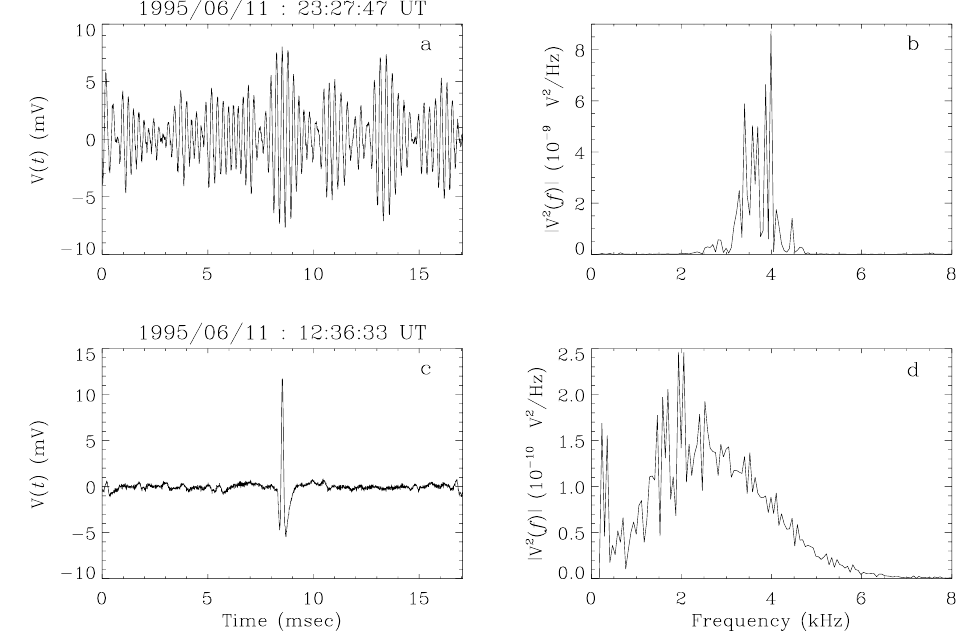
Fig. 1. Electrostatic waveforms observed by the TDS instrument in the solar wind. (a) and (b) packets of quasi-sinusoidal waves, and their spectrum. (c) and (d) an isolated weak double layer and its